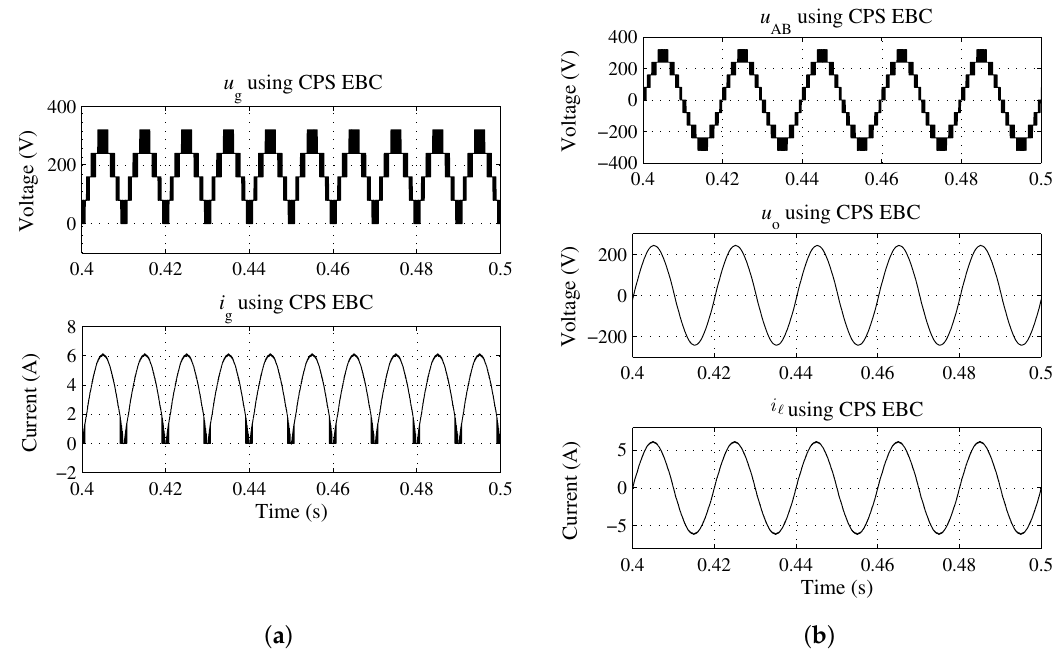
Figure 8. The simulation results of the nine-level prototype. ( a ) The output voltage u g and current i g of the first stage; and ( b ) The output voltage u o and current i o of the second stage.